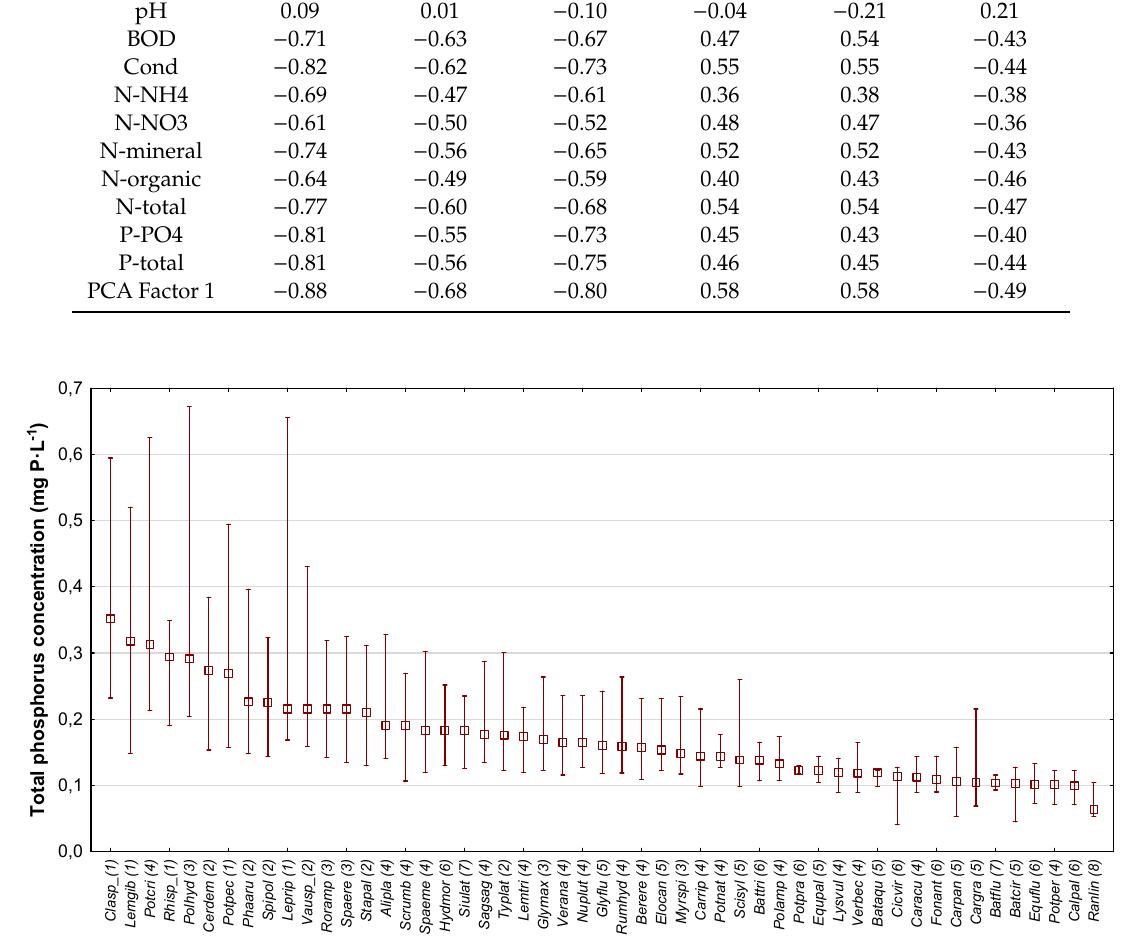
Table 5. Comparison of Pearson’s correlation coe ffi cients (r) between macrophyte metrics and environmental variables in Polish lowland rivers ( n = 100). Significant correlations at p < 0.05 are marked in red. Variable MIR IBMR MTR RMNI ITEM RI pH 0.09 0.01 − 0.10 − 0.04 − 0.21 0.21 − 0.71 − 0.74 − 0.56 − 0.55 P-total − 0.81 − 0.56 − 0.75 PCA Factor 1 − 0.88